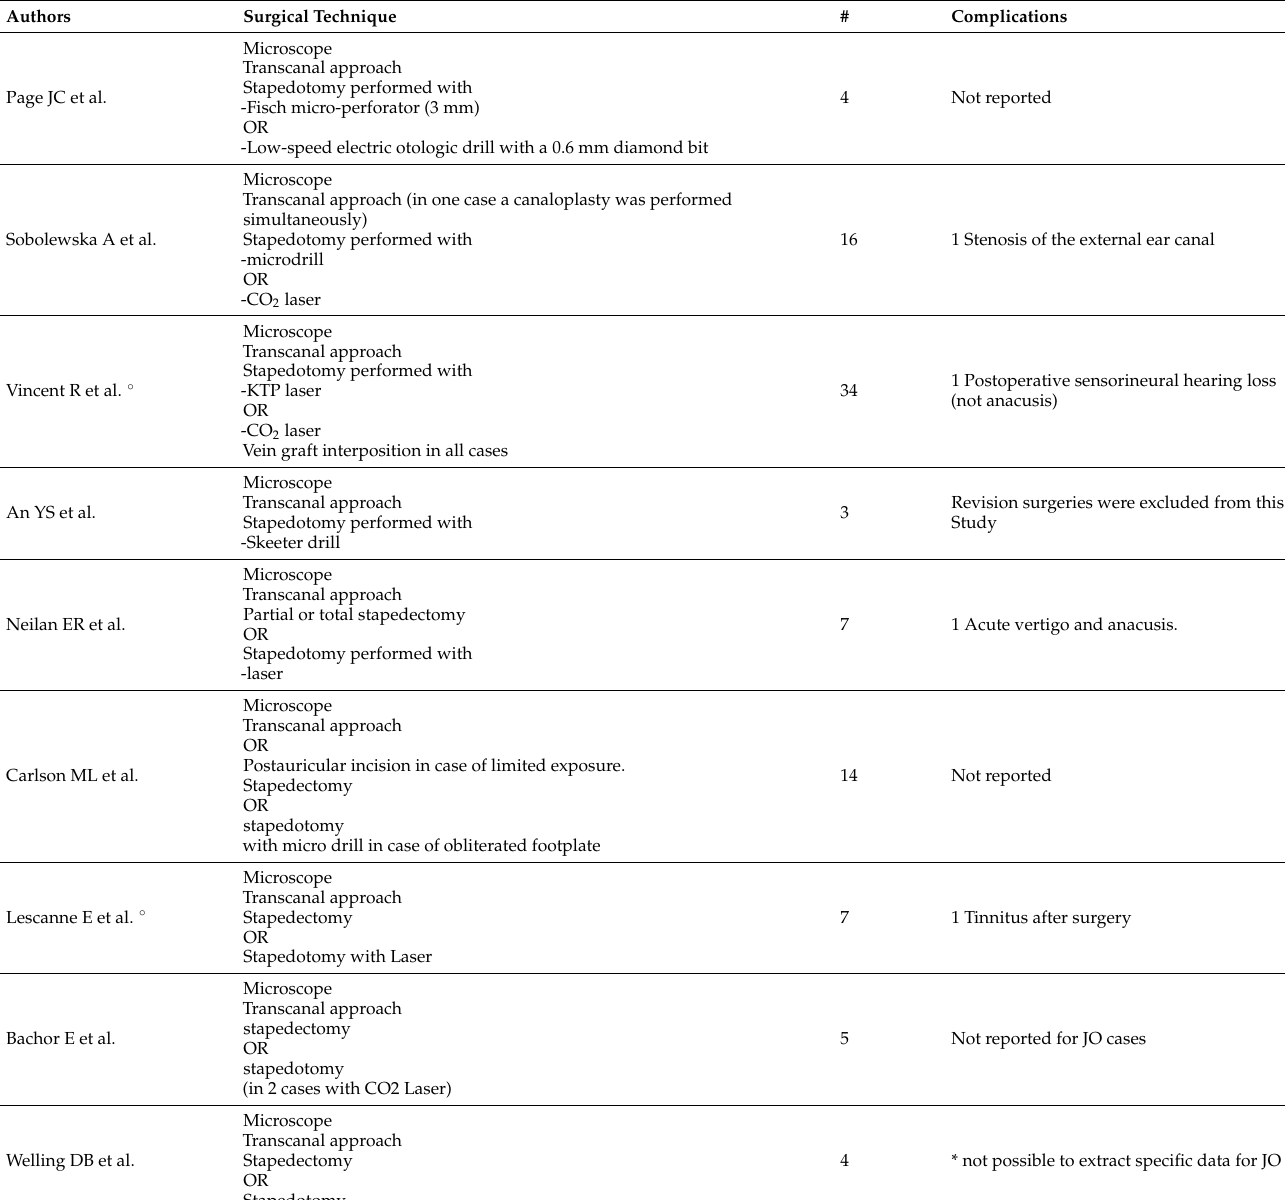
Table 4. surgical technique, complication reported. * = not possible to extract this specific data on JO patients; # = case studies; ◦ = studies focused only on